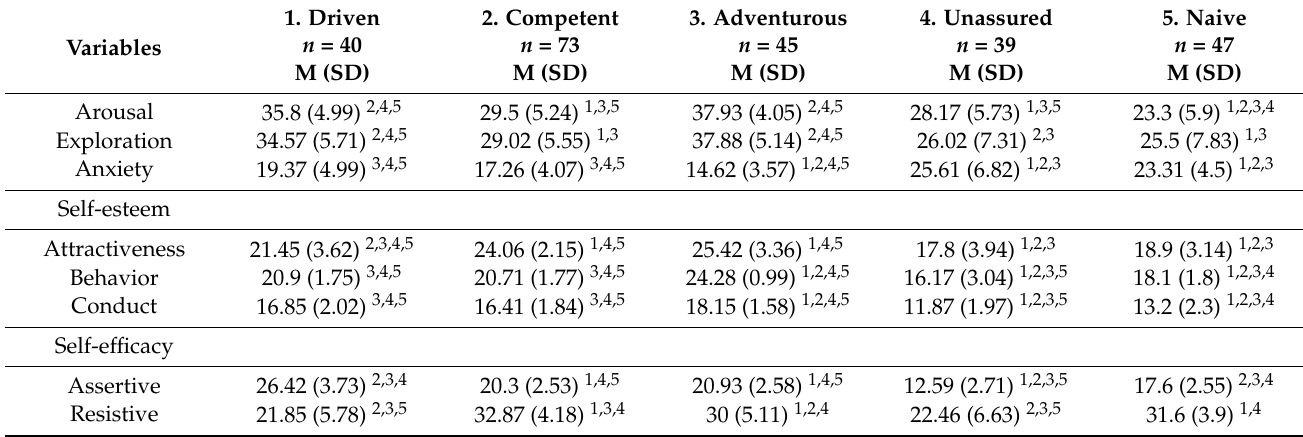
Table 1. Cluster